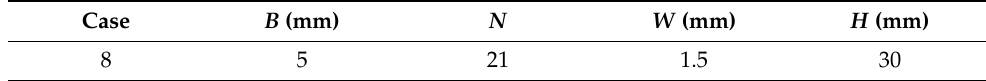
Table 7. The optimal combination for the geometric